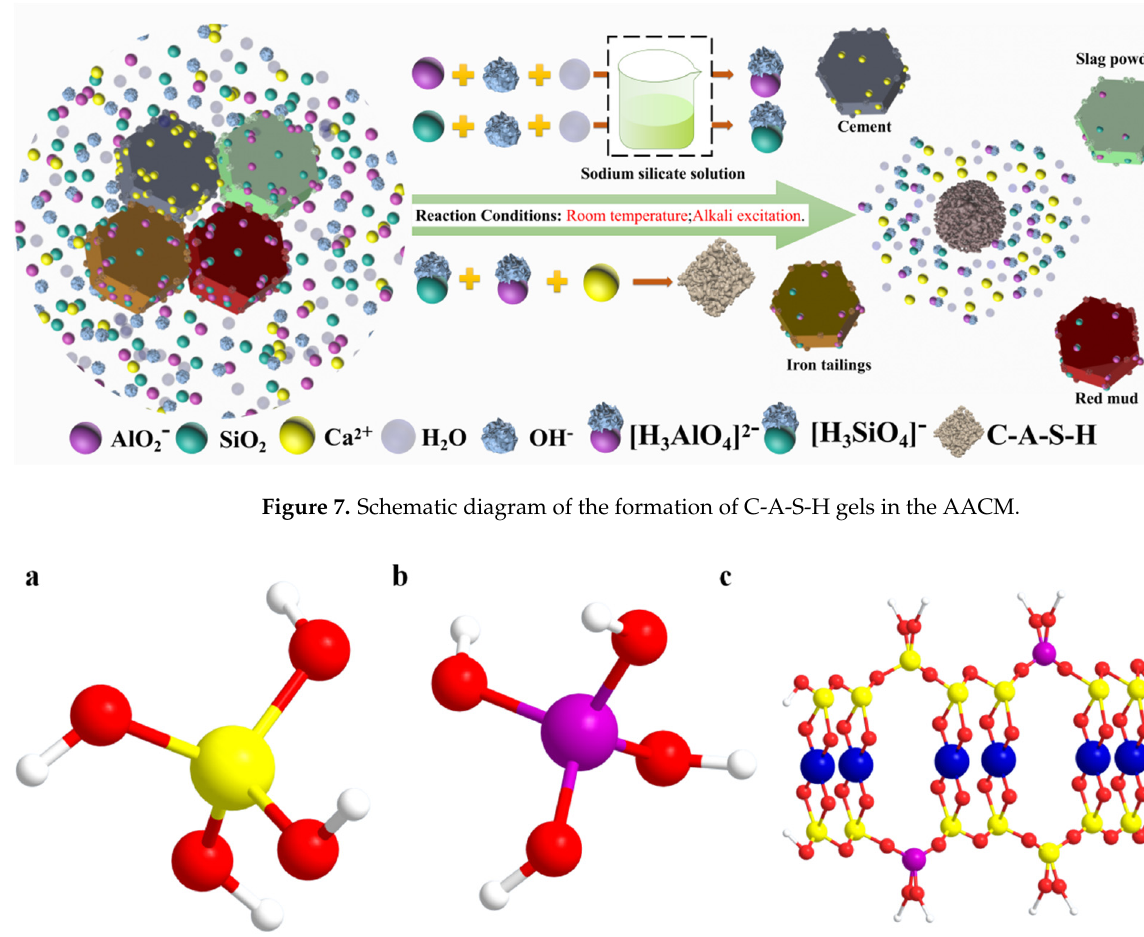
Figure 8. Structural model. ( a : [H 3 SiO 4 ] − , b : [H 3 AlO 4 ] 2 − , and c : C-A-S-H gel).